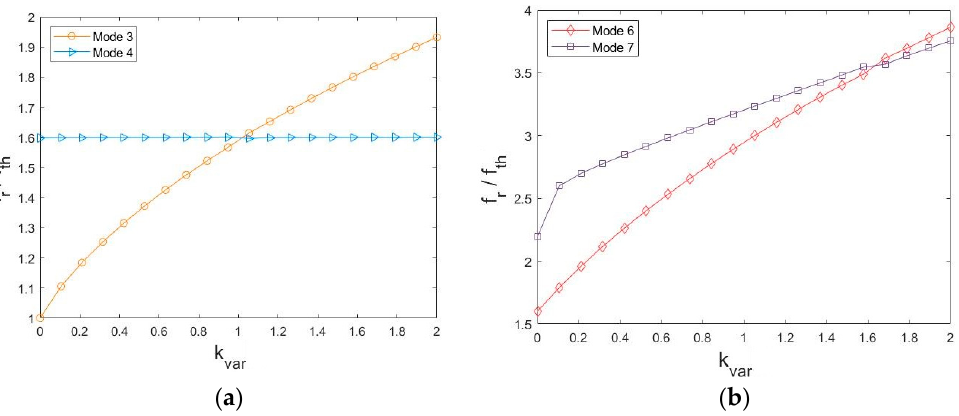
Figure 6. Re-ordering of modes: ( a ) modes 3 and 4; ( b ) modes 6 and 7.